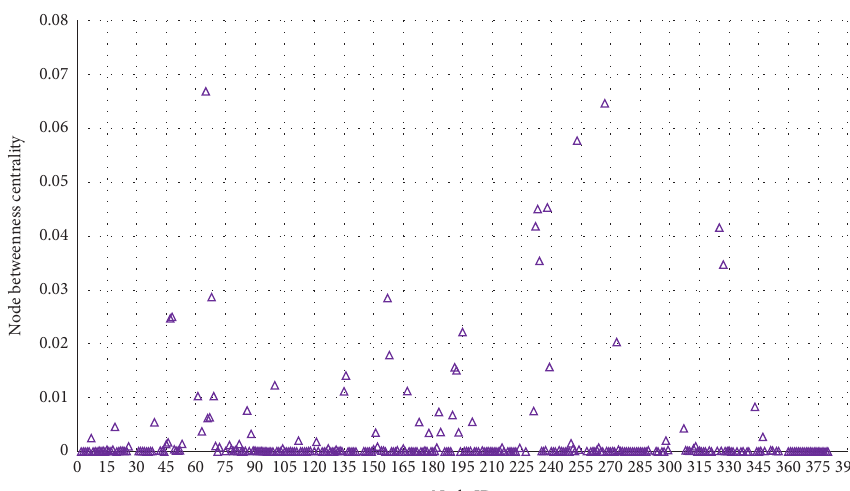
Figure 8: Betweenness centrality of nodes in the